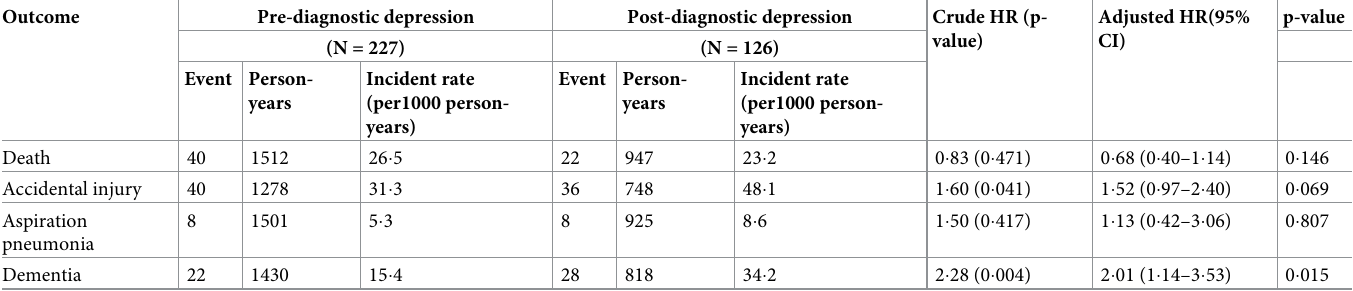
Table 2. Incidence and hazard ratio of outcome variables associated with pre-diagnostic and post-diagnostic depression in Cox’s regression